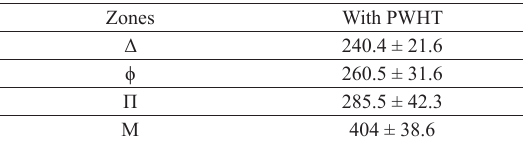
Table 9. Average values and standard deviation of microhardness tests (HV 0.1